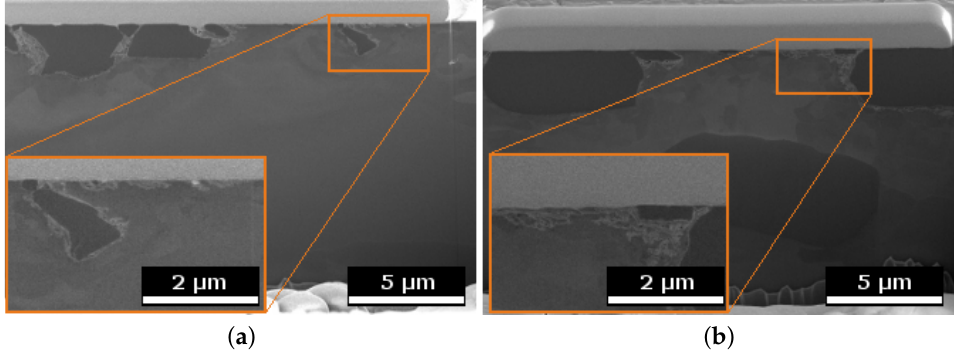
Figure 12. SEM images of FIB cross sections in worn surfaces of the pins with 10.4% Si; ( a ) as-cast, ( b )